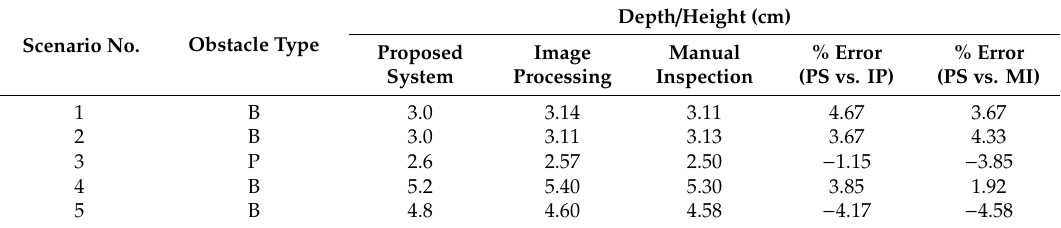
Table 10. Comparison of latitude between the proposed system (PS), image processing (IP), and manual inspection (MI) for the R1 test site.